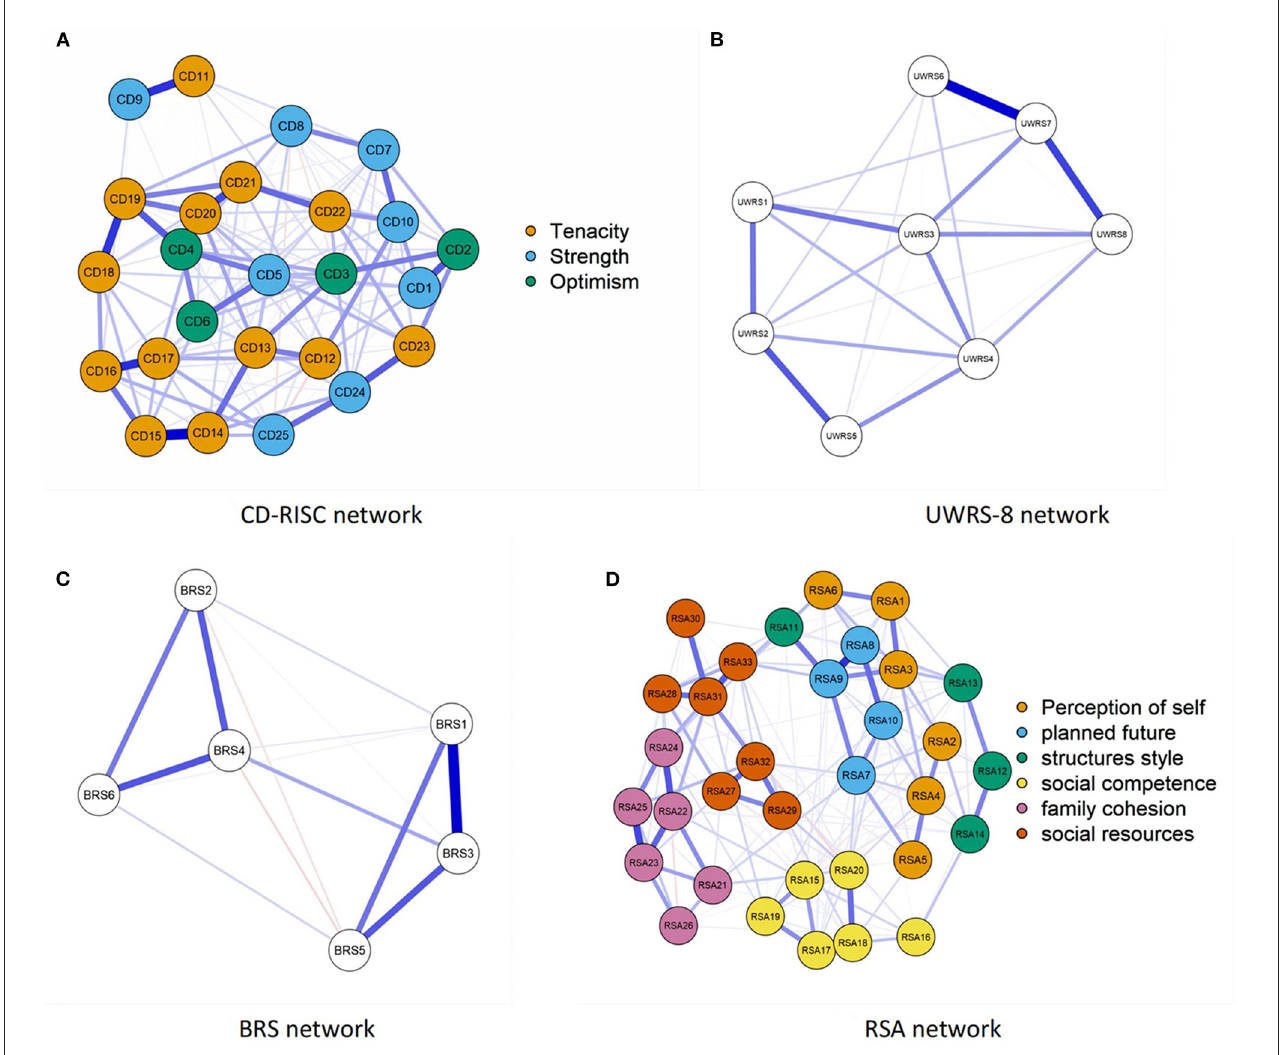
FIGURE1 Structure of factors’ network of resilience as measured by four single scales. (A) CD-RISC network. (B) UWRS-8 network. (C) BRS network. (D) RSA network.